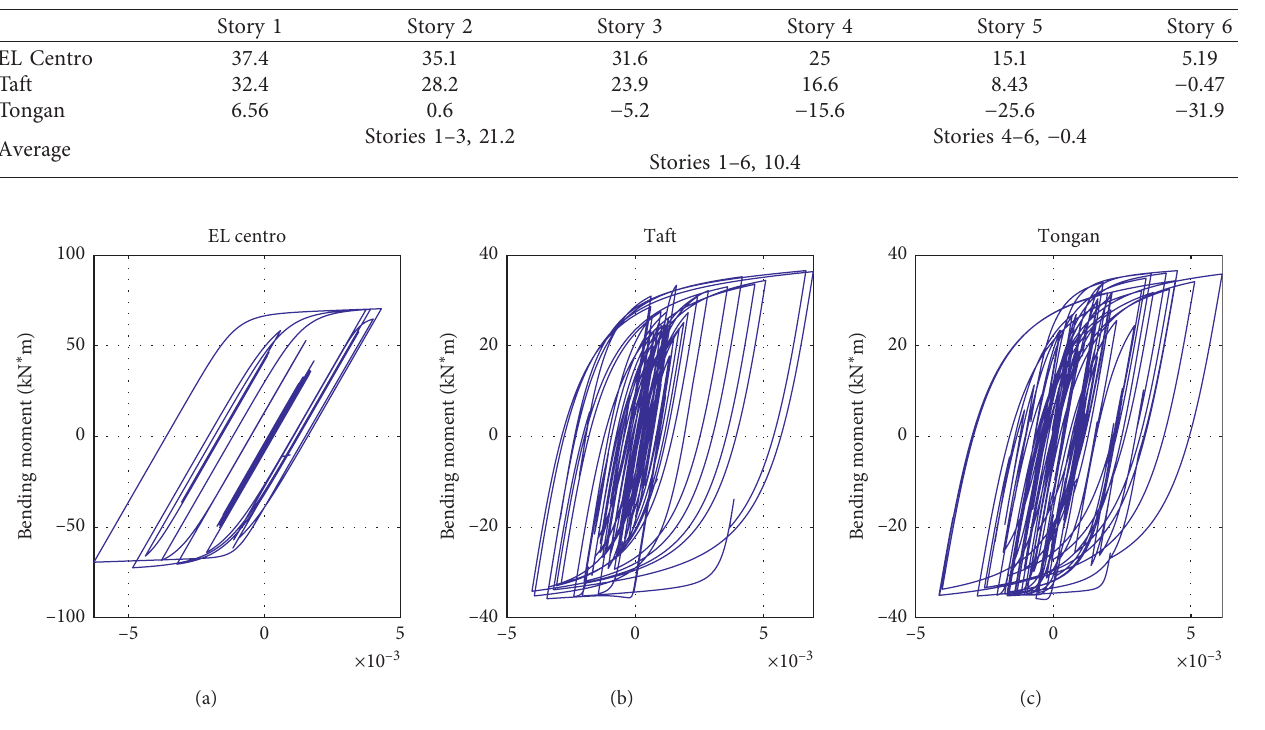
Figure 18: Hysteretic energy dissipation of damper in bending